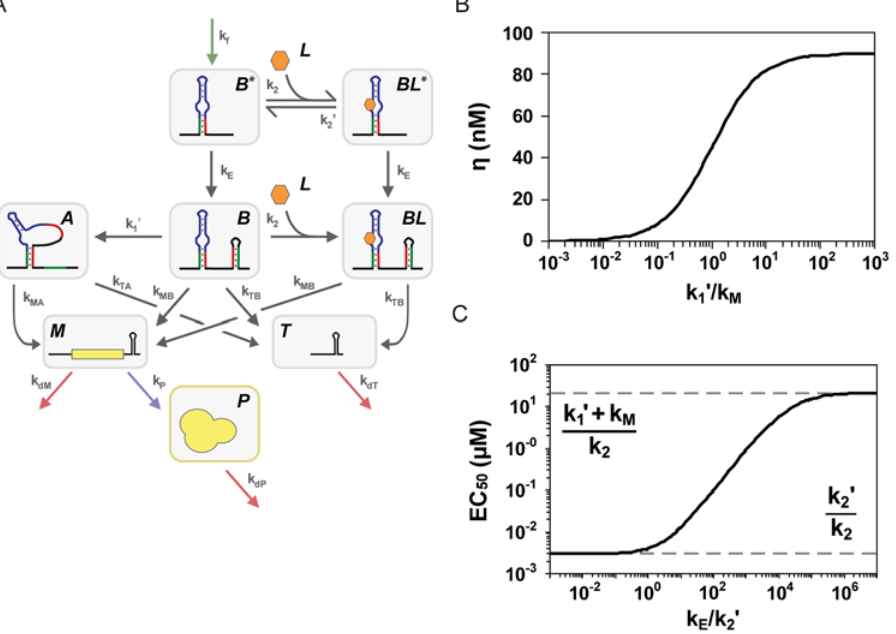
Figure 4. Rescuing riboswitch performance in the non-functional regime. (A) Molecular description of a non-functional riboswitch functioning through transcriptional termination. The description is identical to that in Figure 1C with notable exceptions: the aptamer in conformation B is transcribed first (B*) and can reversibly bind and release ligand before the terminator stem is transcribed (k E ), and terminator stem formation (k M =k MA + k TA =k MB + k TB ) occurs much faster than ligand release (k 2 9 ) and the progression from conformation A to B (k 1 ). (B) The competition between terminator stem formation (k M ) and the progression from conformation B to A (k 1 9 ) determines the dynamic range. (C) EC 50 can be tuned independent from the dynamic range. The accessible range of EC 50 values is bounded by the aptamer association constant (K 2 =k 2 /k 2 9 ), the rate constant for the progression from conformation B to A (k 1 9 ), and the rate constant for terminator stem formation (k M ). EC 50 is tuned over this range by the rate constant representing the delay between aptamer formation and transcription of the terminator stem (k E ). Parameter values: k 2 =10 6 /M ? s; k 2 9 =3 ? 10 2 3 /s; K A =k P ? k MA /k M =10 2 3 /s; K B =k P ? k MB /k M =10 2 2 /s; k f =10 2 11 M/s; k dP =10 2 3 /s; k dM =10 2 3 /s; k 1 9 + k M =20/s.